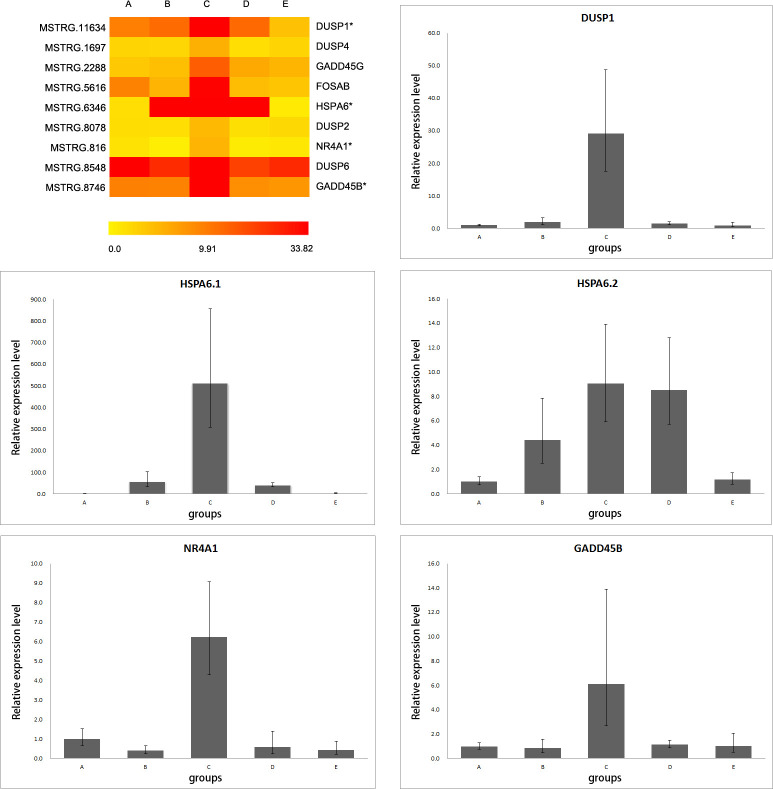
Comparison of RNA-seq profiles with RT-qPCR data.a. Heatmap of differentially expressed genes with TPM in RNA-seq data. b1-b5. Expression profiles of DUSP1, HSPA6 (HSPA6.1, HSPA6.2), NR4A1 and GADD45B with the RT-qPCR results.